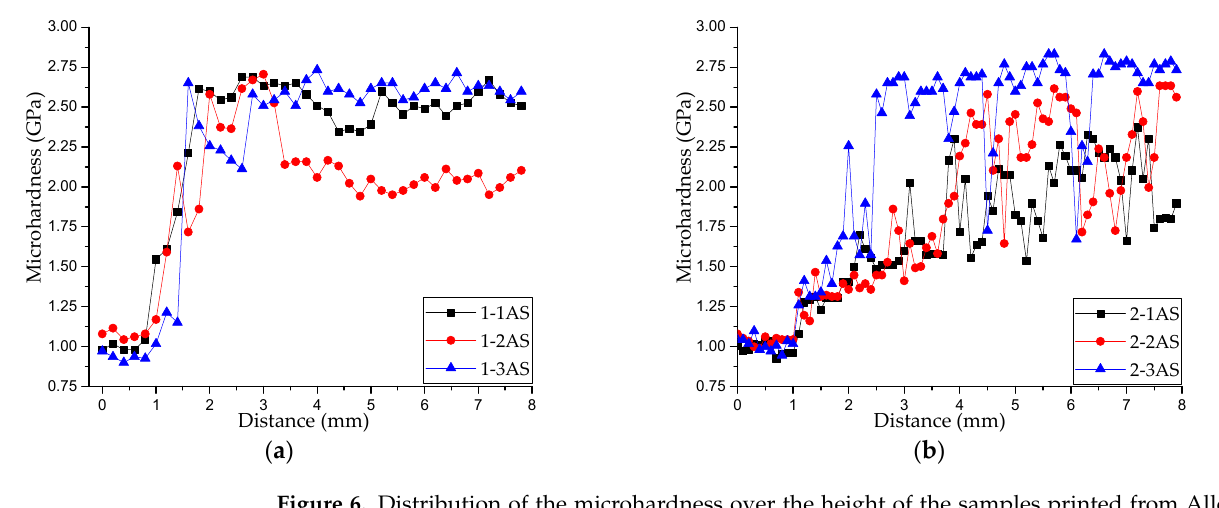
Figure 6. Distribution of the microhardness over the height of the samples printed from Alloy 1 ( a ) and Alloy 2 ( b ).